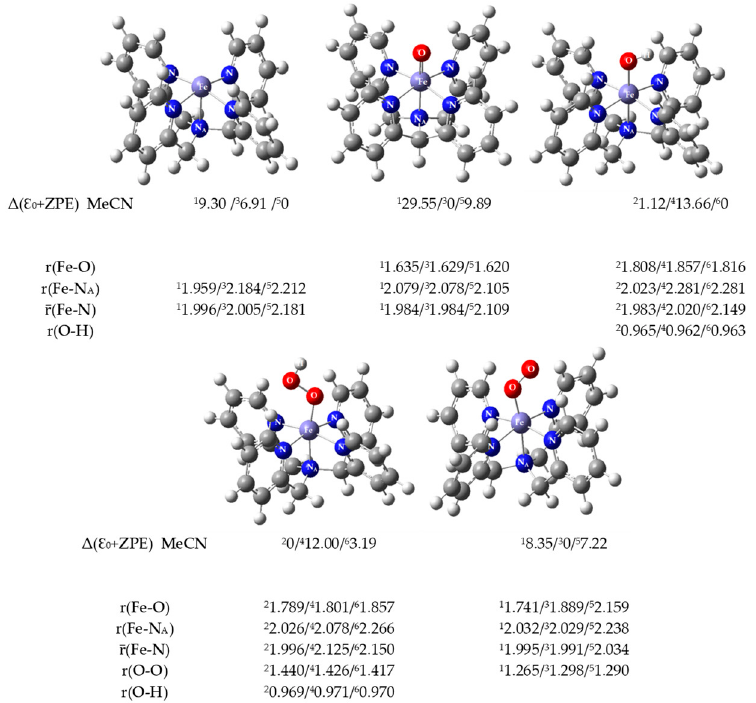
Figure 6. Optimized structures, visualized with GaussView, of iron complexes with relative elec- tronic energies (in kcal/mol). The zero energy level corresponds to the most stable structure in the multiplicity examined. The key bond lengths (in Å) are presented for 1 -singlet/ 3 -triplet/ 5 -quintet or 2 -doublet/ 4 -quarted/ 6 -sextet states, respectively. Def2TZVP method with MeCN as the PCM model.